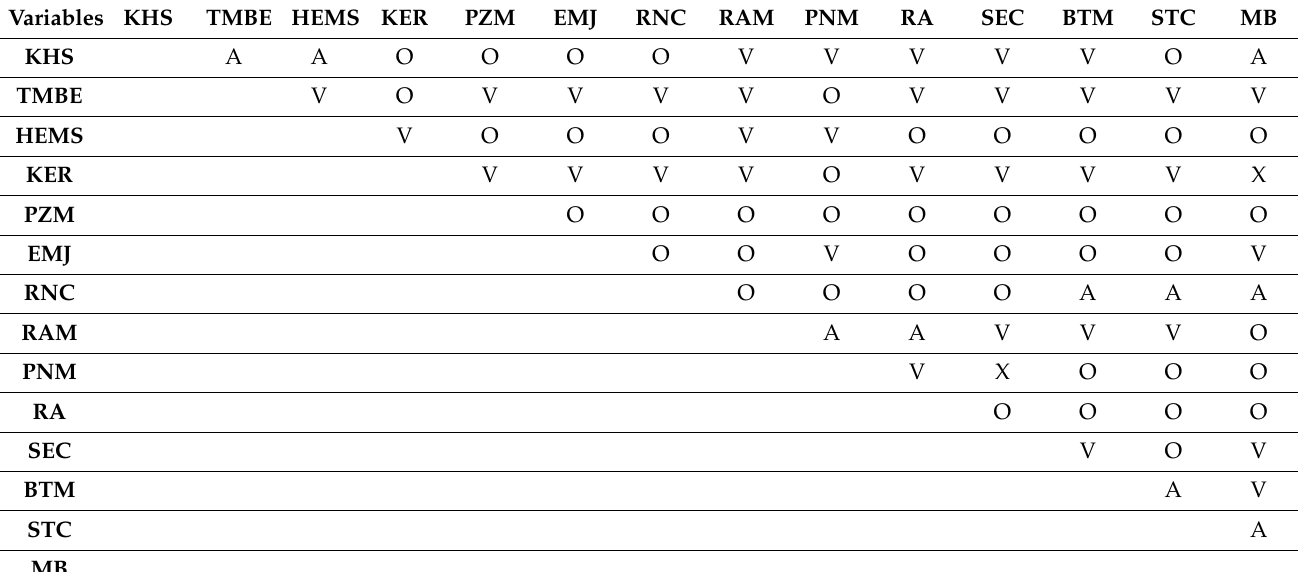
Table 6. SSMT matrix (Ref: